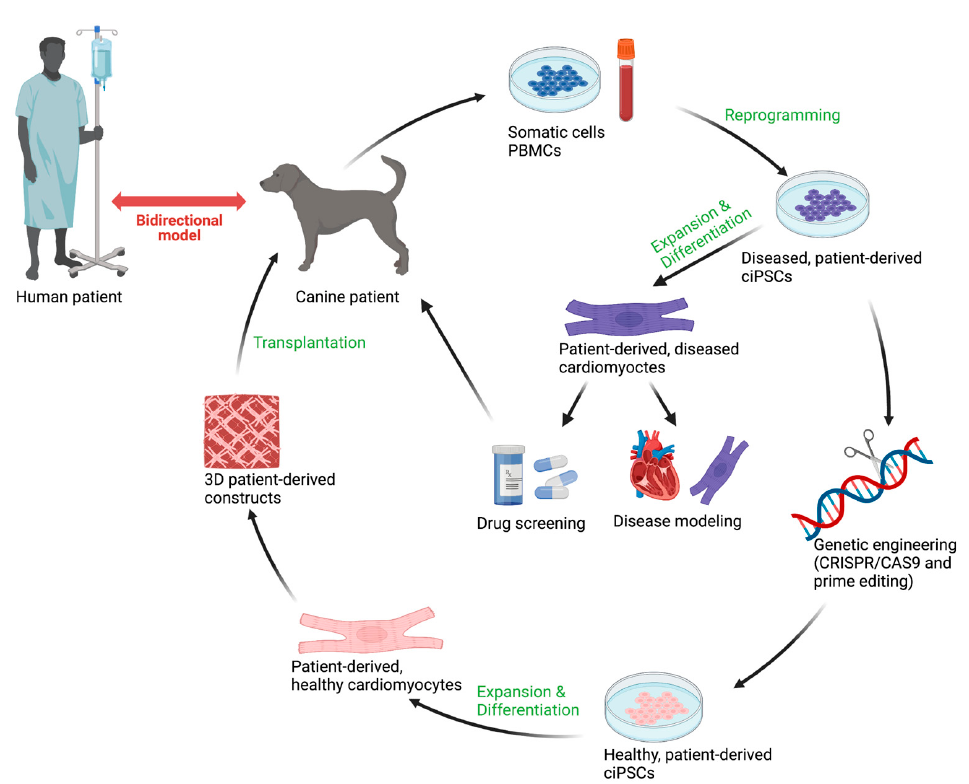
Figure 2. Strategy for applying canine induced pluripotent stem cells (ciPSCs) as a bidirectional model for genetic cardiomyopathies. Patient-specific ciPSC-cardiomyocytes can be used for both drug screenings and disease modeling. With the additional application of genetic engineering, healthy, patient-derived ciPSCs can be created and used for more advanced therapeutic modeling purposes. Advances made in the canine and human fields can be translated across species boundaries. Created with BioRender.com.